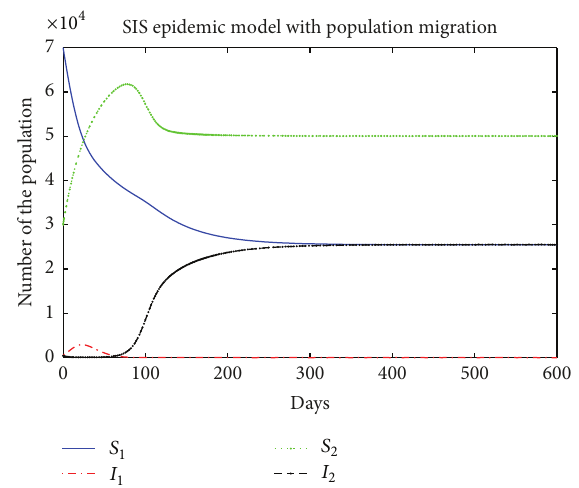
Figure 2: Evolution trajectories of the SIS epidemic model.